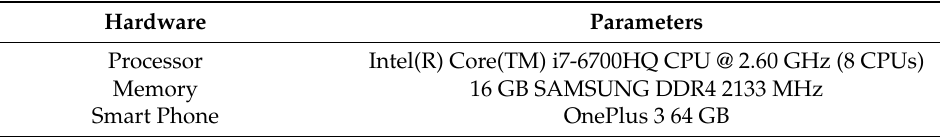
Table 2. Hardware parameters.